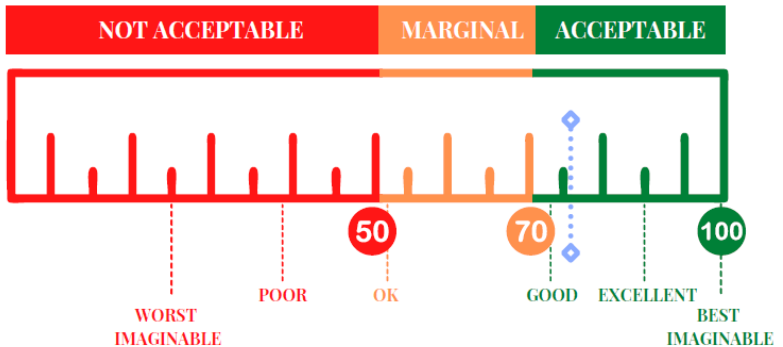
Figure 3. A graphic representation of the SUS score. Specifically, according to the cut-off score (cut-off = 68), more than 70% of participants showed scores above the cut-off. In addition, according to the adjective rating, 35.5% of subjects evaluated the EXIT 360 ◦ as ‘Good’, 32.9% as ‘Excellent’, and 27.6% as ‘Best imaginable’ [71]. Pearson’s or Spearman’s correlation showed no significant linear correlation between the SUS total score and the demographic characteristics, particularly for age (r = − 0.045, p = 0.699) and education (r = − 0.096; p = 0.405). Moreover, data showed the absence of a significant correlation between the SUS total score and the total score of the EXIT 360 ◦ (r = 0.126; p =